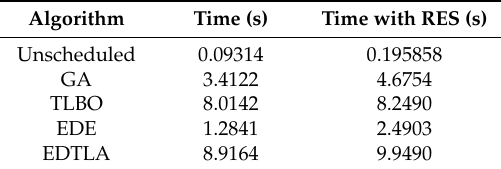
Table 5. Execution